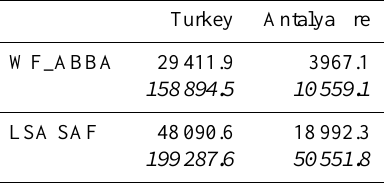
Table 1. Total particulate matter estimates [tons] in the study area and for Antalya fire from WF_ABBA and LSA SAF FRP-pixel products during Antalya fire lifetime (31 July and 5 August 2008), using conversion factors and emission coefficients described in Kaiser et al. (2012) (referring to Andreae and Merlet, 2001) boosted by 3.4 and Ichoku and Kaufman (2005) smoke emission coeffi- cients. The estimates based on Ichoku and Kaufman (2005) are set in italics below the ones referring to Andreae and Merlet